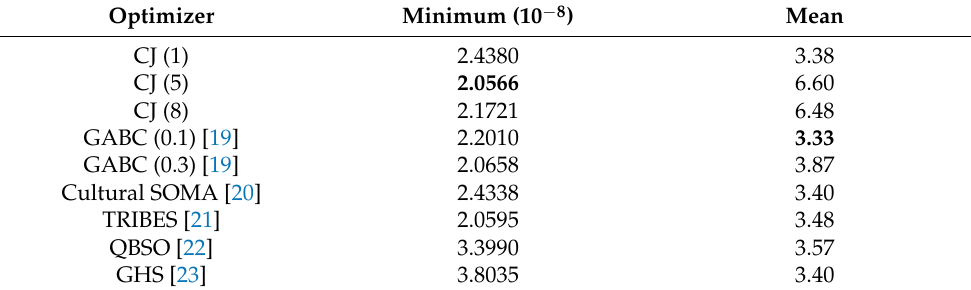
Table 4. Results in terms of the objective function f ( s , l ) · 10 − 8 . Data in bold font indicates the smaller values.